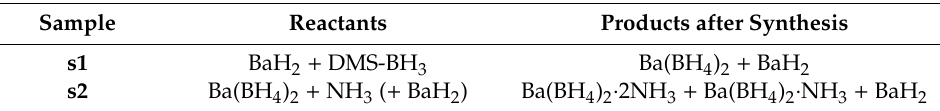
Table 1. Sample overview.